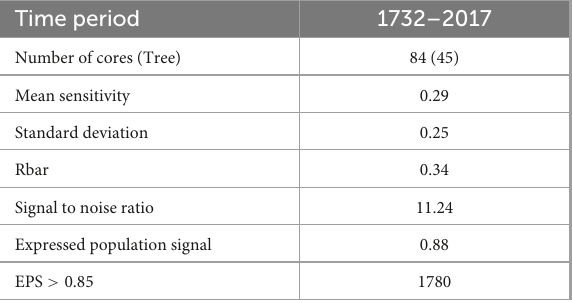
TABLE 1 Statistics of developed tree ring chronology of Rhododendron arboreum .